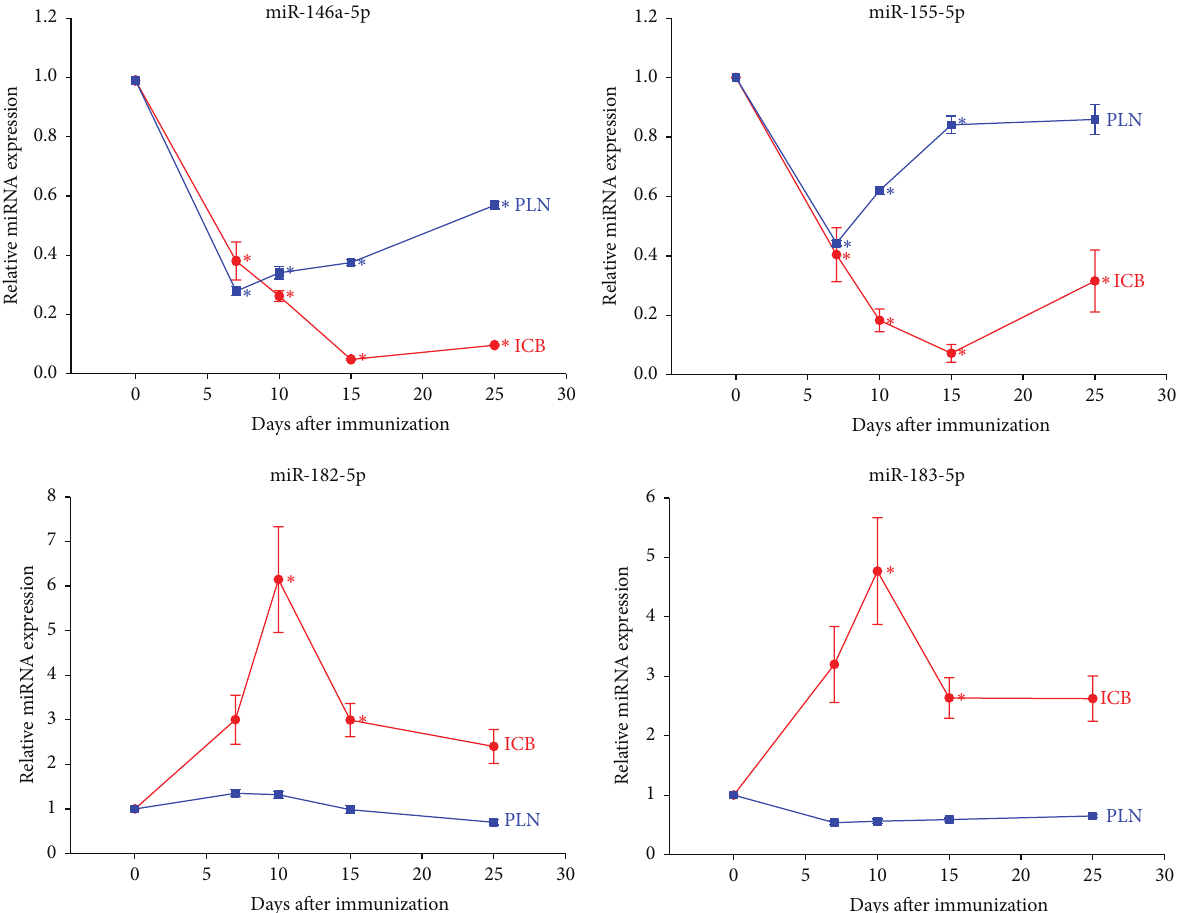
Figure 3: Respective dynamic expression levels of microRNAs in iris/ciliary bodies and popliteal lymph nodes. ∗ Significant differential expression among study and control eyes ( 𝑃 < 0.05 ). ICB: iris/ciliary body tissue; PLN: popliteal lymph nodes. miR-146a-5p and miR-155-5p: downregulation of miRNA in PLN reached its lowest point at day 7 after immunization, while that in ICB reached its lowest point at day 15 after immunization. miR-182-5p and miR-183-5p: upregulation of miRNA in ICB peaked at day 7 after immunization, while dynamic changes of miRNA expression in PLN did not reach significant difference among the study and control groups at any specific time